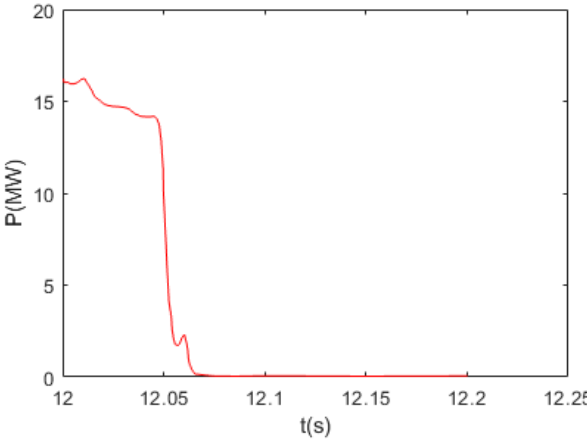
Figure 10. Single arrester power curve under the fault f18.